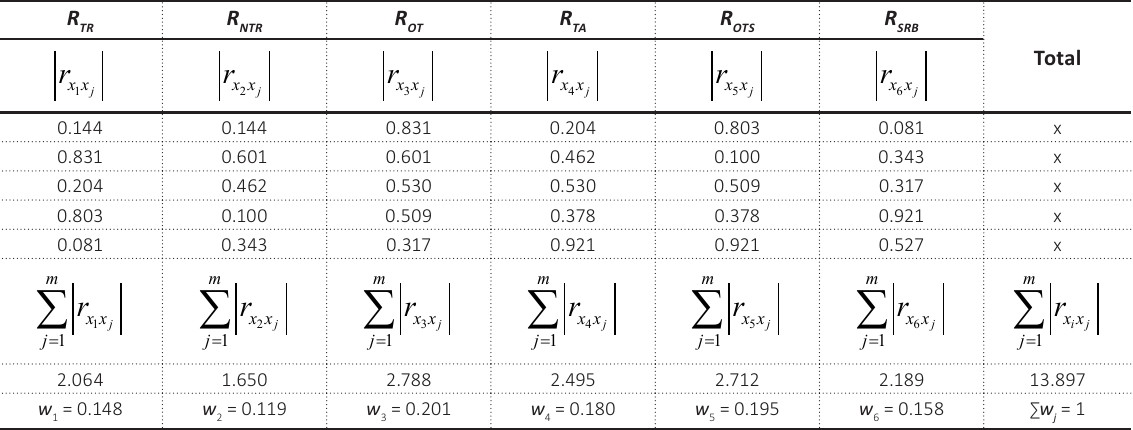
Table 10. Calculation of the weighting coefficients of the single indicators of the component of the level of decentralization of intergovernmental budgetary relations